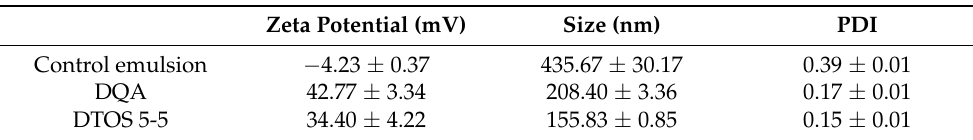
Table 2. Size and zeta potential of dequalinium (DQA) emulsion and α -TOS/DQA 5-5 emulsion (DTOS